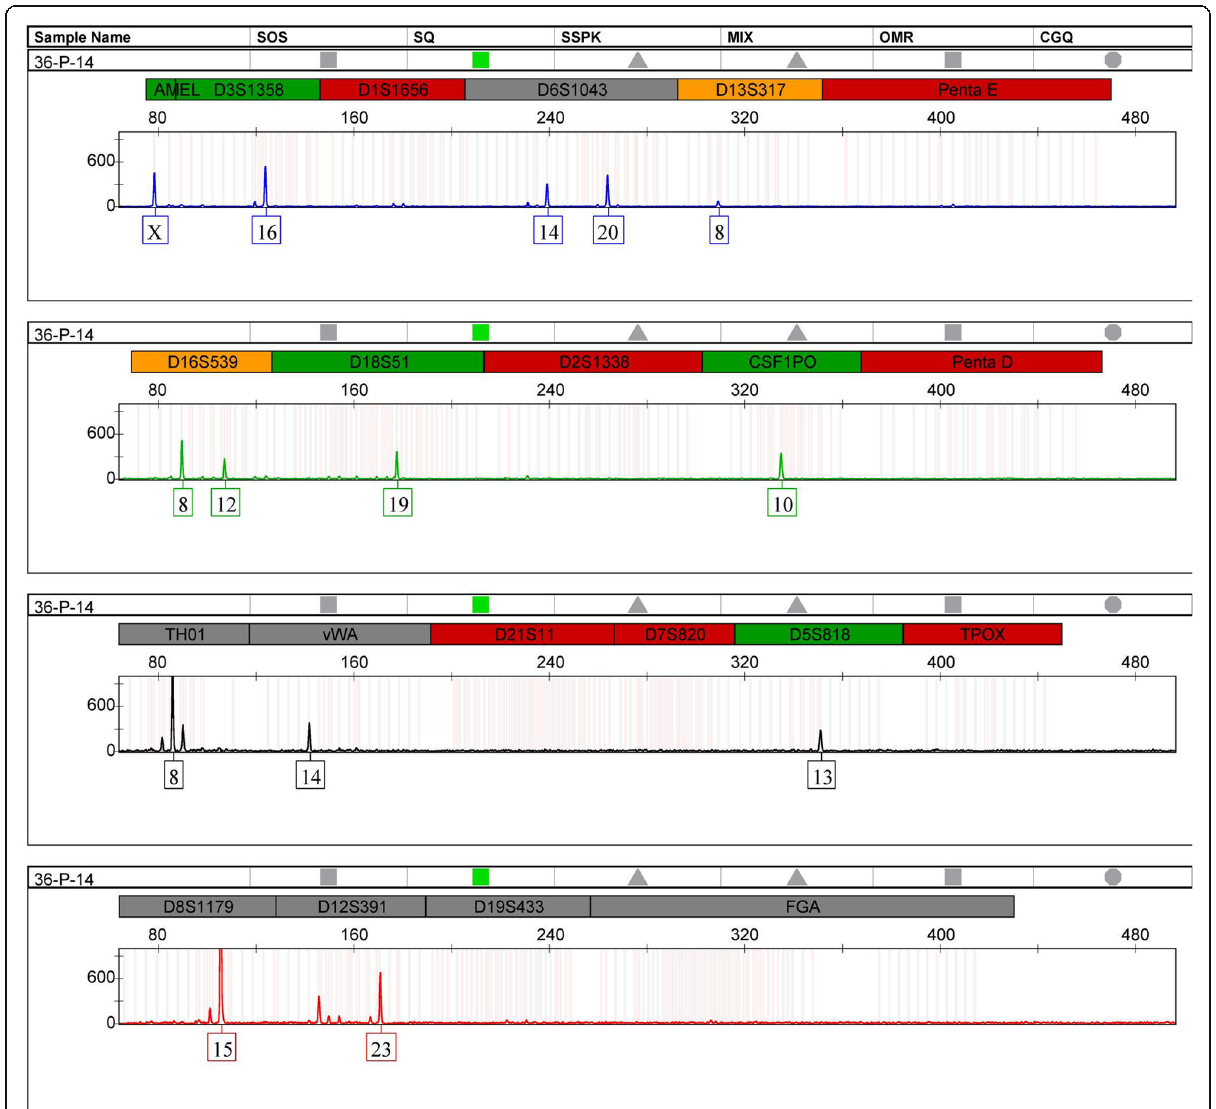
Fig. 3 Electropherogram of prostate tissue showing partial